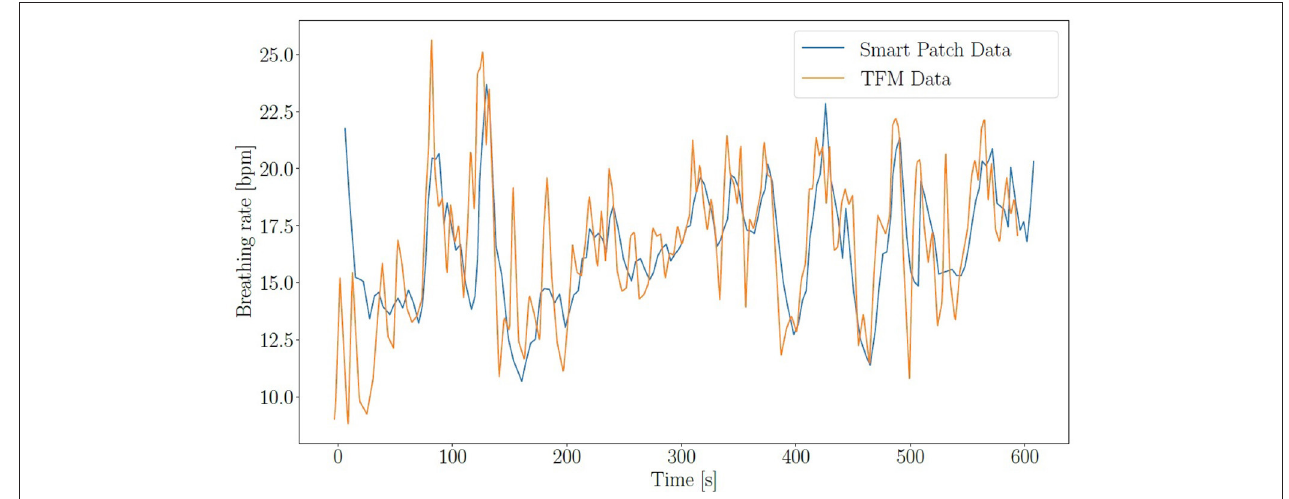
FIGURE 5 | BR over time for SP (blue) and TFM (orange).